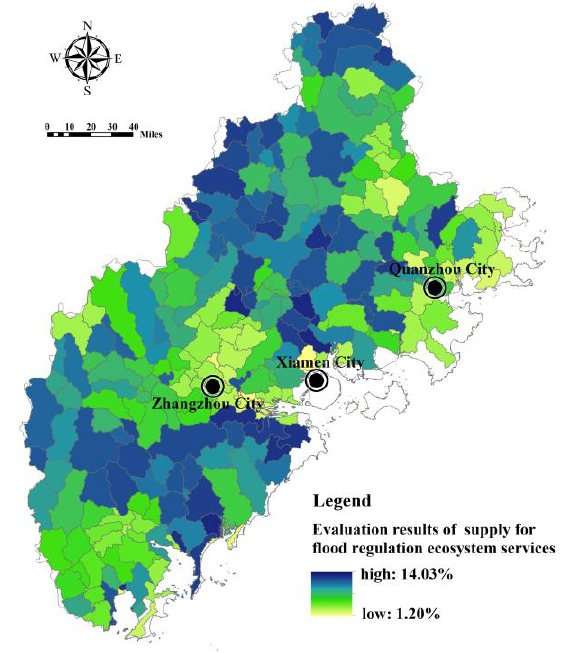
Figure 7. Assessment of FRES supply in Fujian Delta.